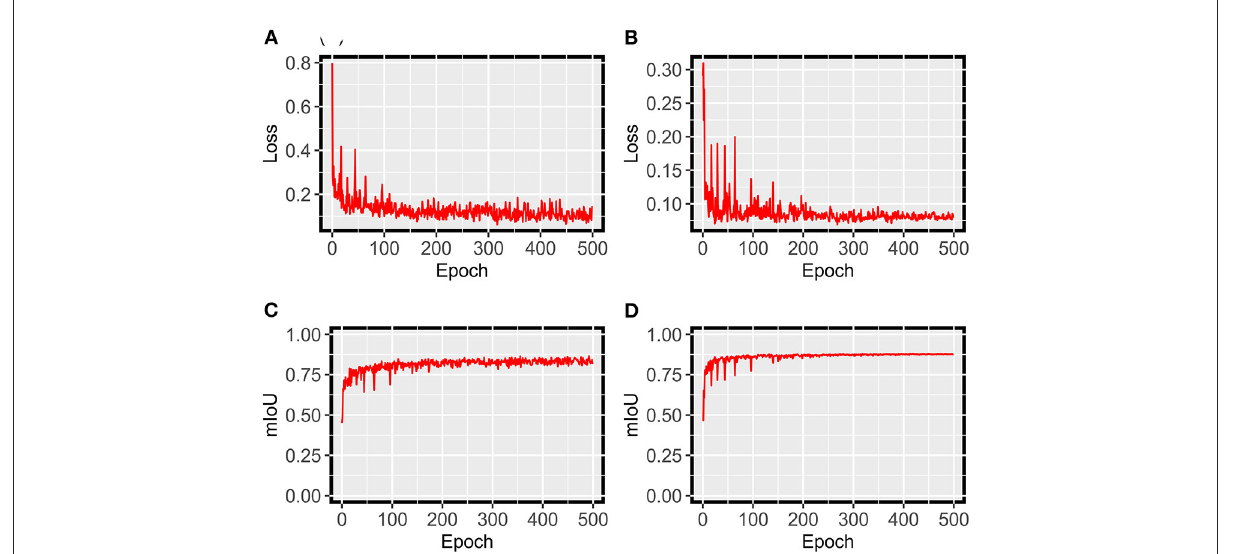
FIGURE4 HMASS training and validation process for DM infection segmentation dataset. Parameters were evaluated after each epoch. (A) Represents the cross-entropy loss evaluated on the training dataset. (B) Represents the cross-entropy loss evaluated on the validation dataset. (C) Represents the mIoU evaluated on the training dataset. (D) Represents the mIoU evaluated on the validation dataset.